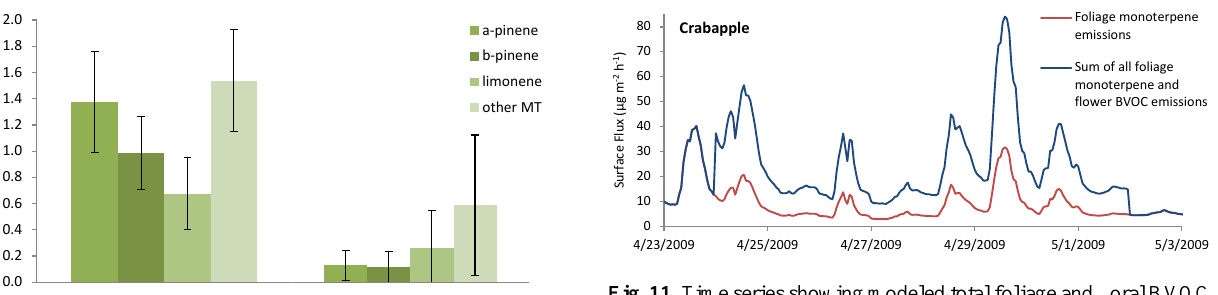
Fig. 11. Time series showing modeled total foliage and floral BVOC emissions (blue) and default MEGAN, foliage monoterpene emis- sions only (red), during the crabapple flowering period for the City of Boulder urban area.